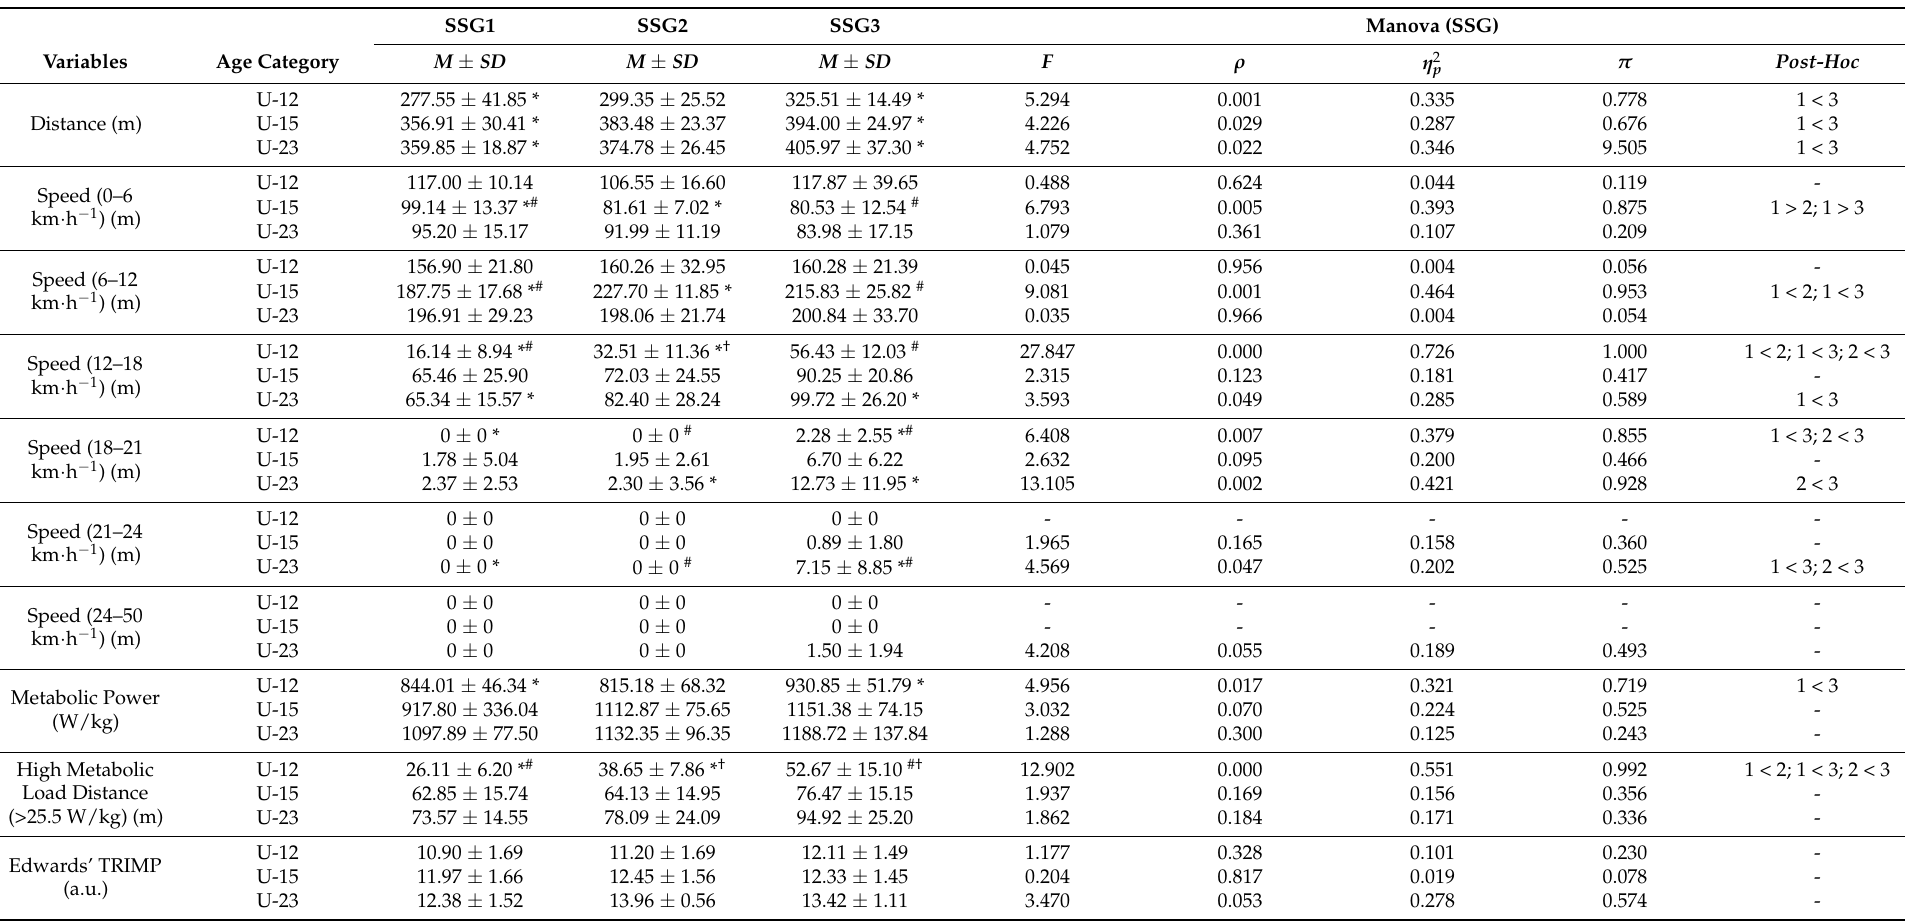
Table 1. Comparison between small-sided soccer games according to age